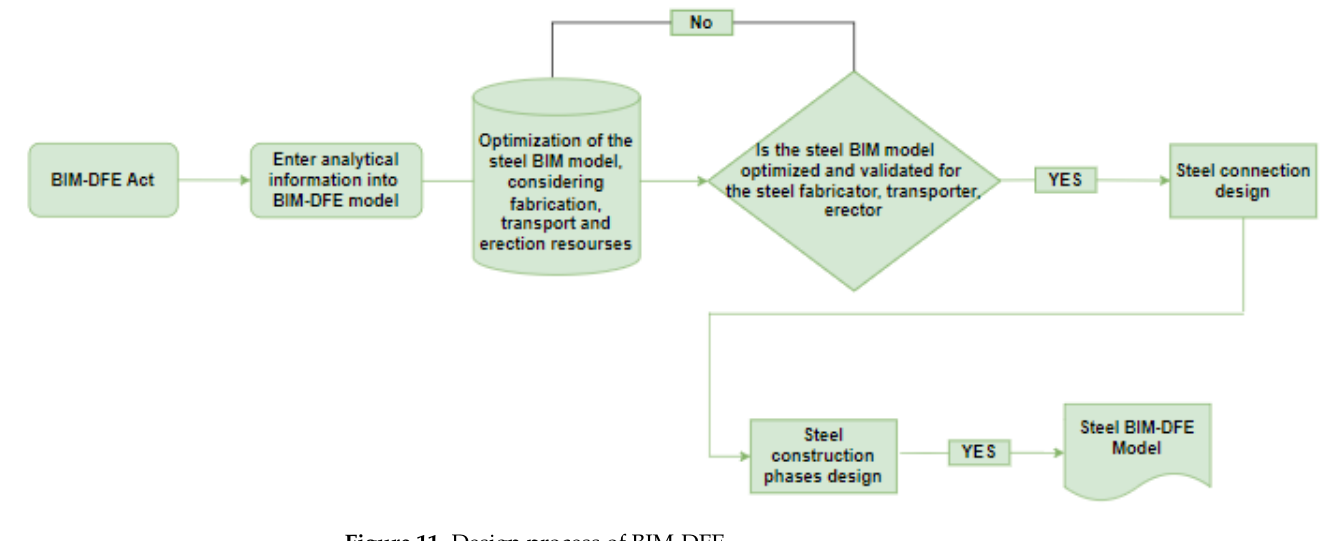
Figure 11. Design process of BIM-DFE.